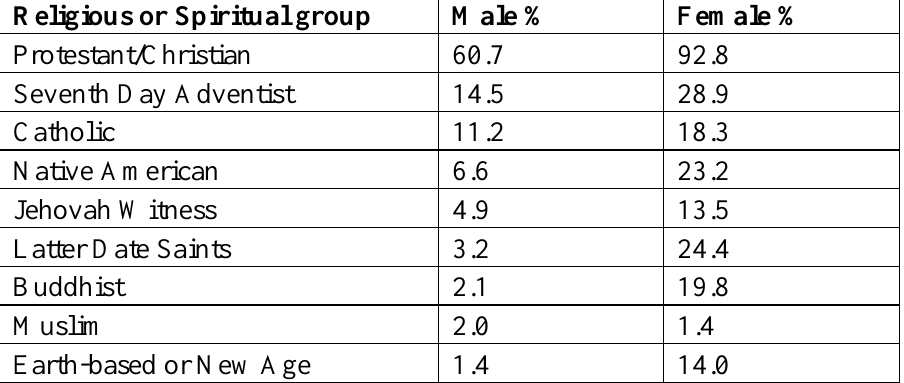
Table 2. Percent of Men and Women Attending Religious or Spiritual Groups.